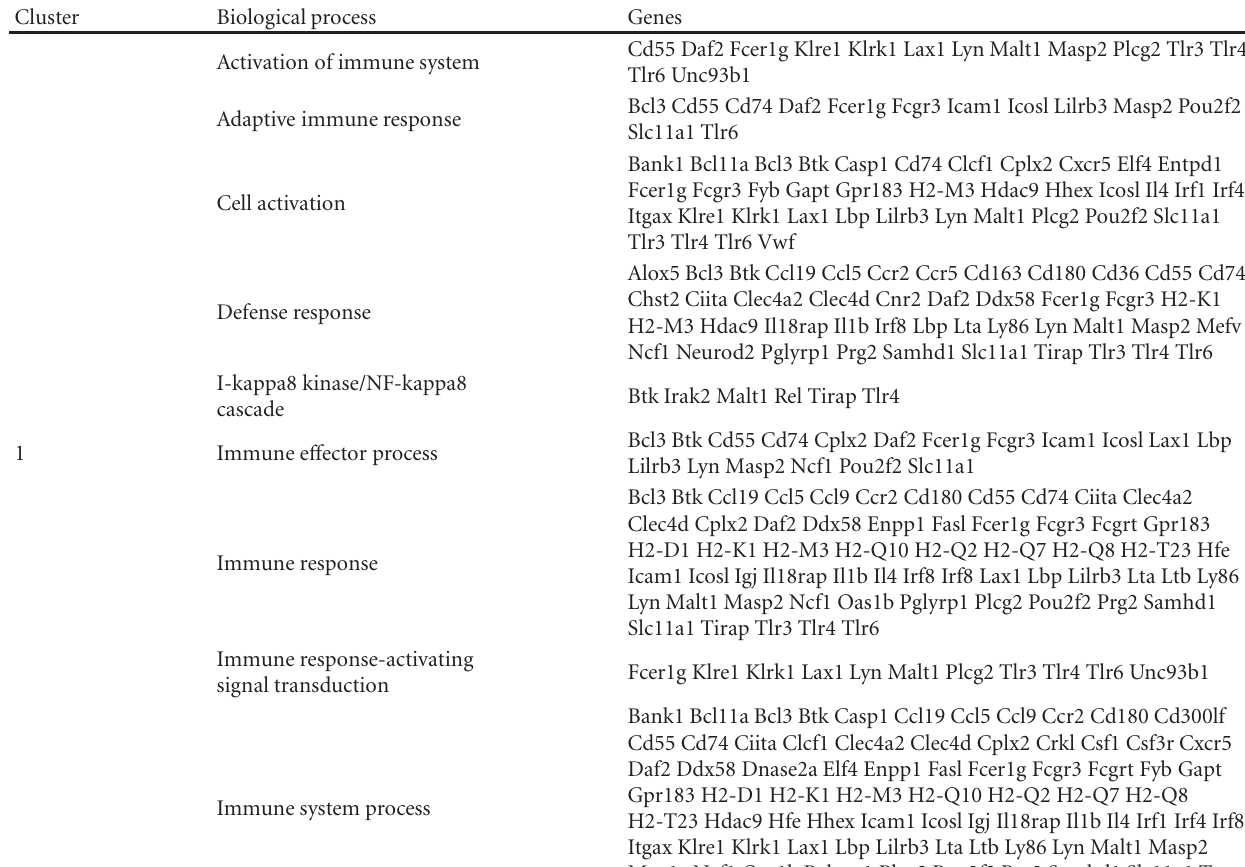
Table 1: Clusters of the di ff erentially expressed genes and their